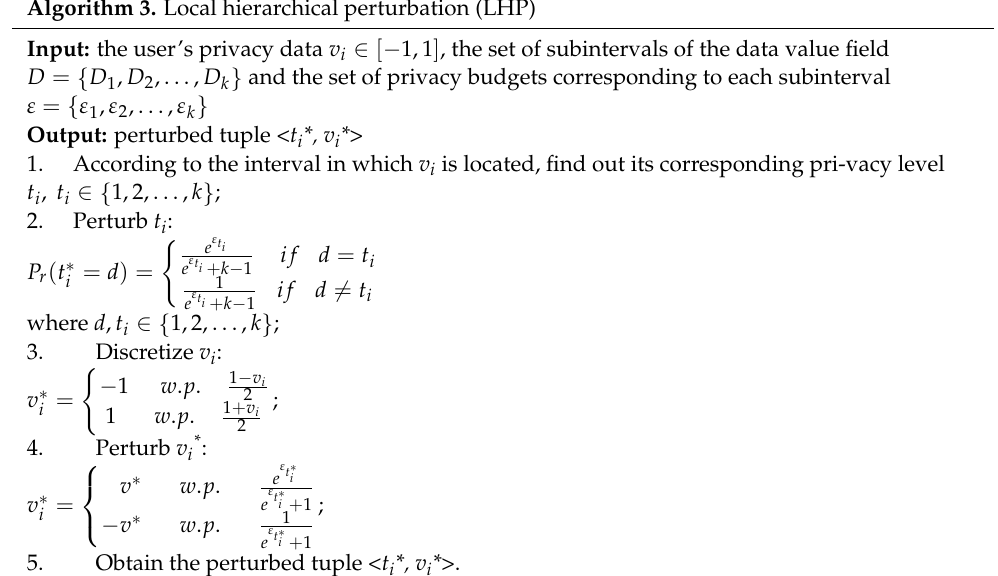
Algorithm 3. Local hierarchical perturbation (LHP)